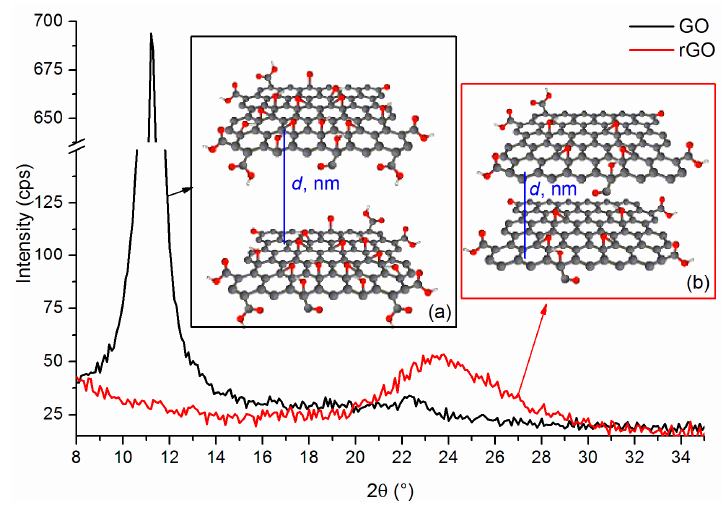
Figure 6. WAXS patterns for ( a ) graphene oxide and for ( b ) reduced graphene oxide.